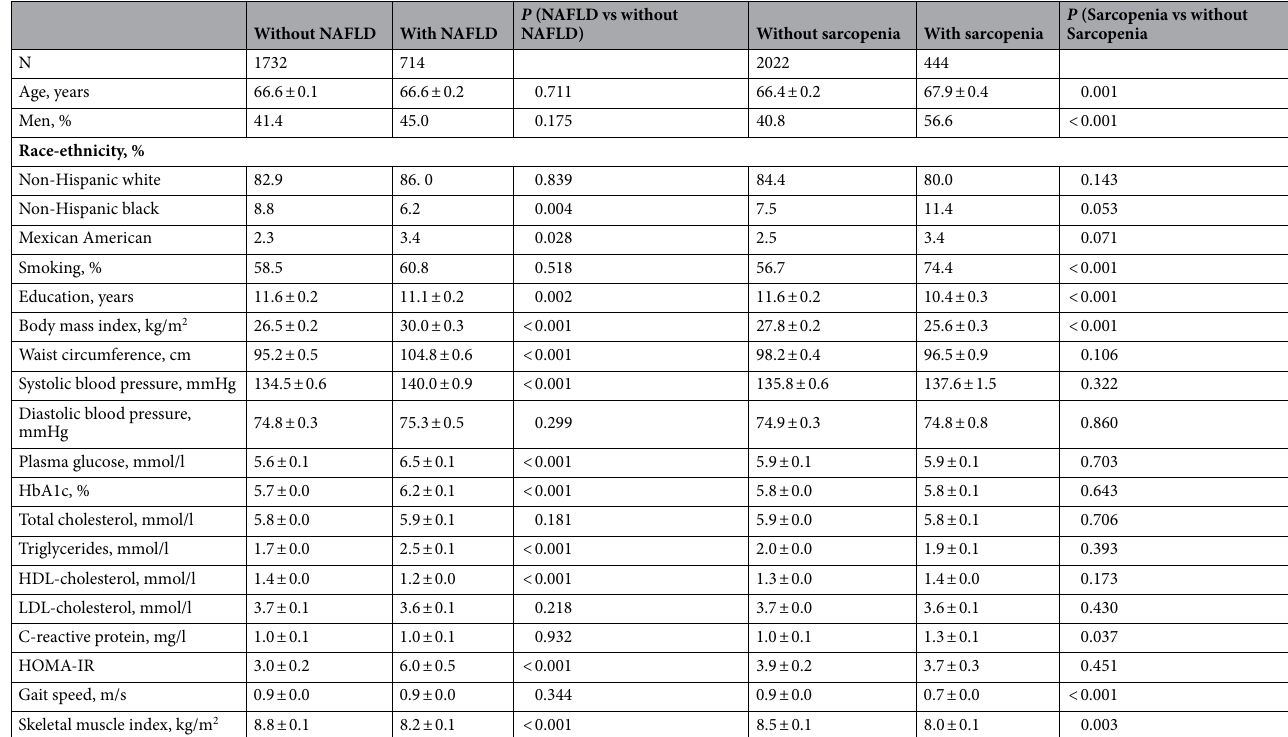
Table 1. Characteristics of the study participants according to the presence of nonalcoholic fatty liver disease or sarcopenia. Data are presented as means ± standard errors or percent. NAFLD nonalcoholic fatty